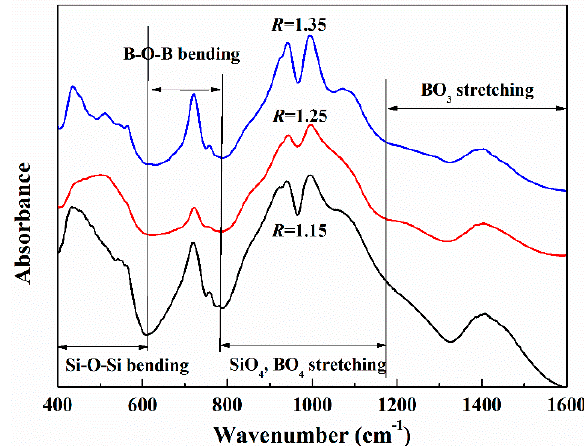
Figure 4. Infrared spectrum of CaO-SiO 2 -B 2 O 3 slag.